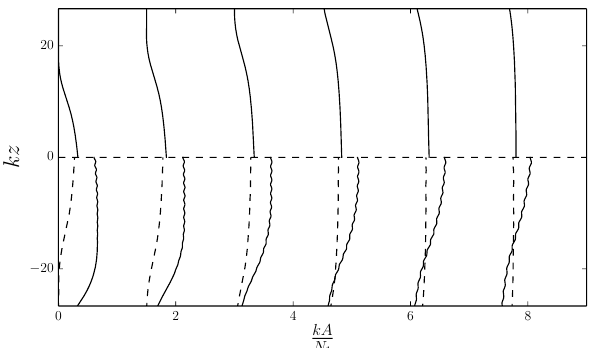
Figure 12. Vertical profiles of the wave magnitude in two layers for a sequence of times. Each profile is shifted by a value of 1.5 for display. The parameter values are n 1 /k = 1, N 2 /N 1 = 2, (cid:15) = 0.025, and α = 0.1.